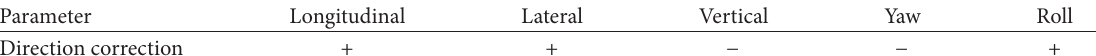
Table 2: Coordinate system of IMU02 correction.